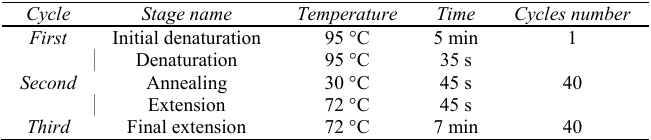
Table 2: Temporal and thermal cycles used in RAPR-PCR